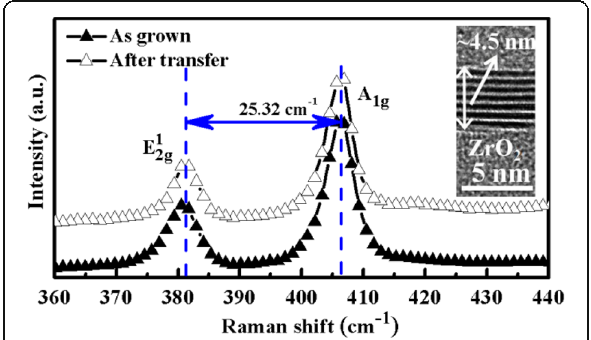
Fig. 1 The Raman spectroscopy of the ultrathin MoS 2 film before and after transfer. The inset is the cross-sectional transmission electron microscopy (TEM) image of the MoS 2 on ZrO 2 /Si substrate, which shows the layers of MoS